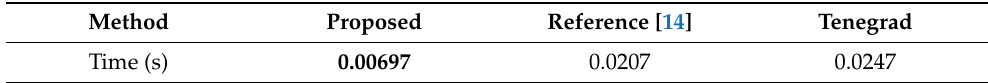
Table 4. Running time